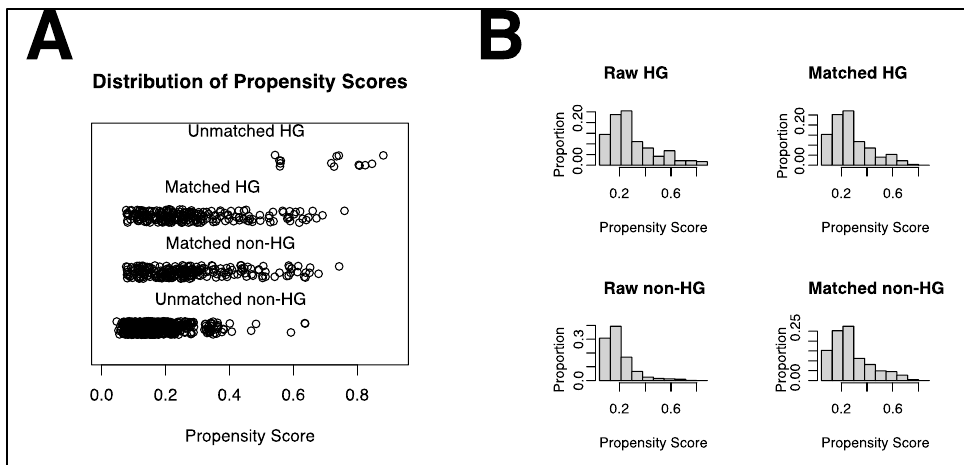
Figure 3. Distribution of propensity scores. ( A ) Jittered plot presenting matched and unmatched subjects, and the distribution of propensity score values. ( B ) Histograms demonstrating the density of propensity score distribution in the hyperglycemia and non-hyperglycemia groups before and after matching. HG, hyperglycemia.